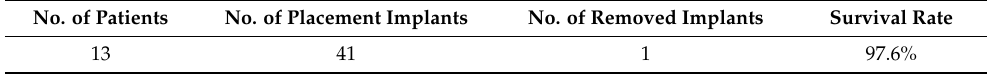
Table 6. Implant